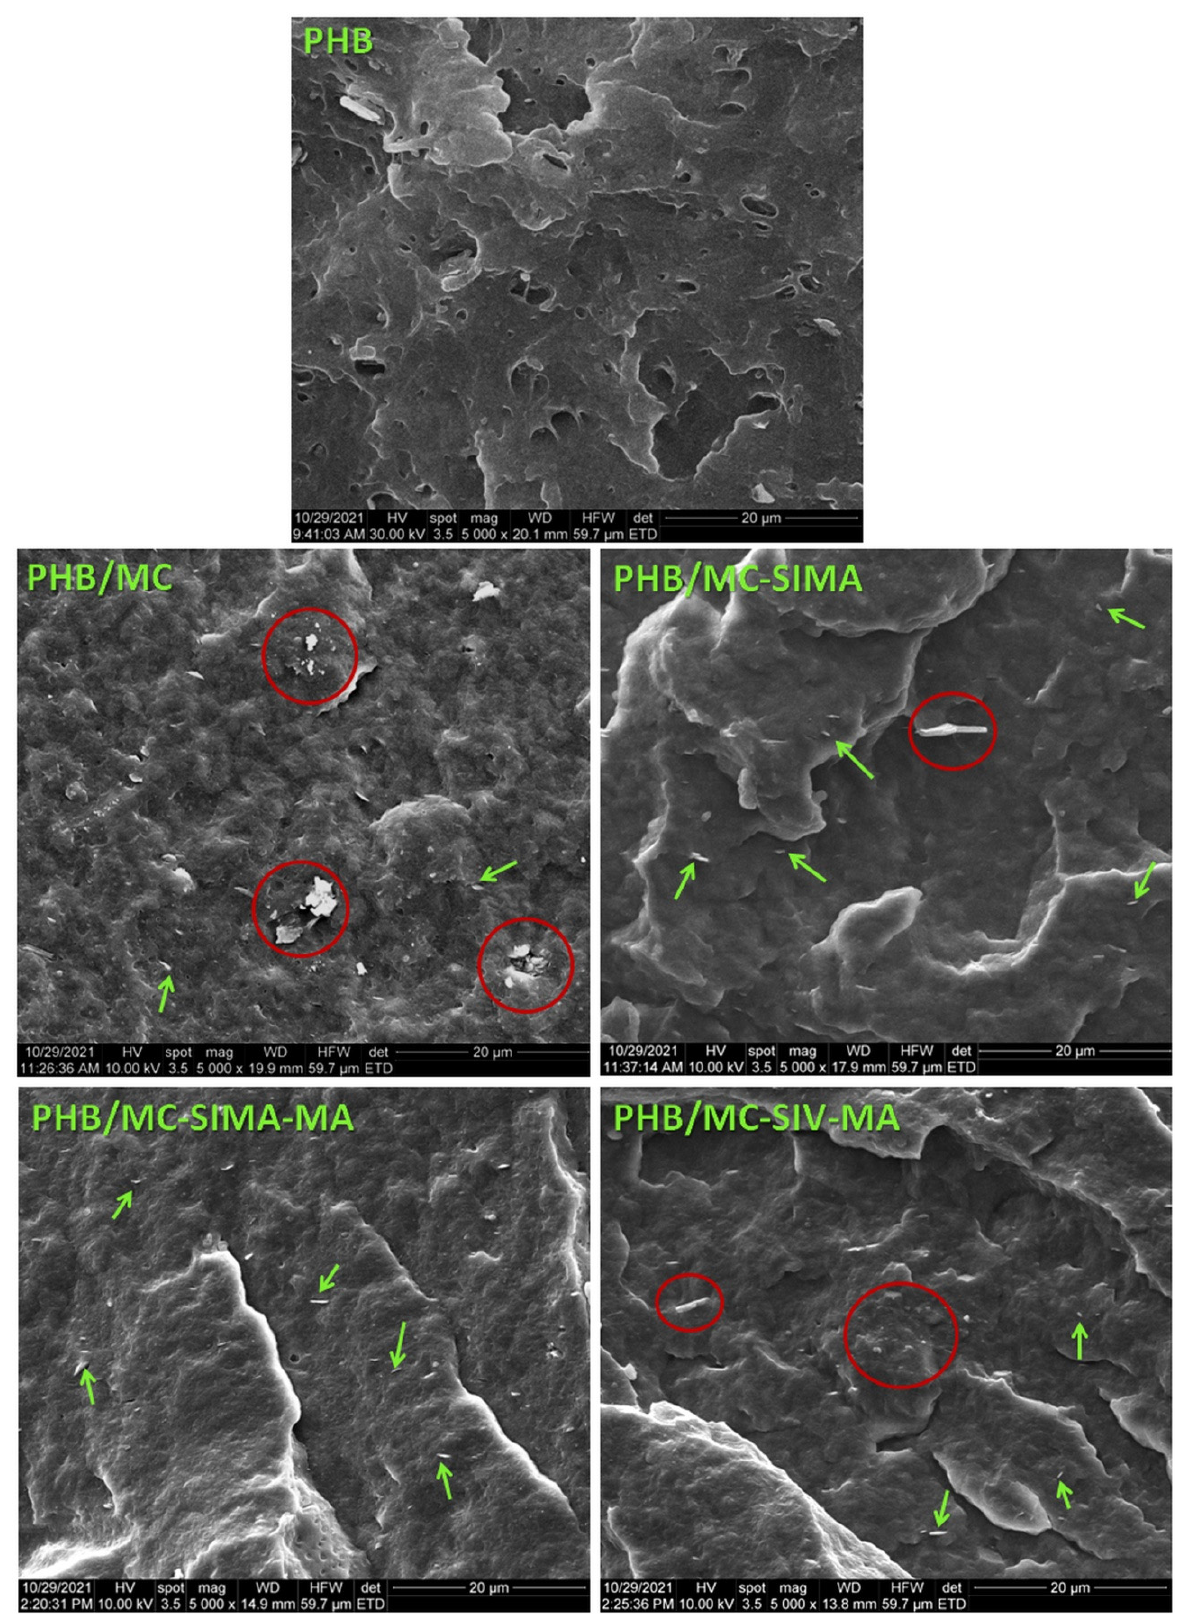
Figure 11. SEM images of PHB and composites frozen in liquid nitrogen and fractured .